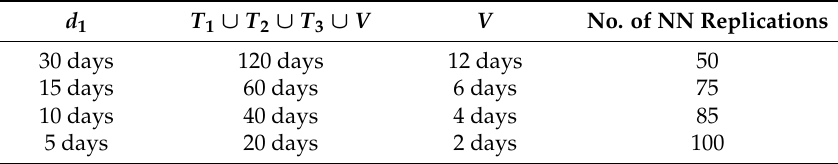
Table 2. Training and validation sets for NN forecasting on unstable